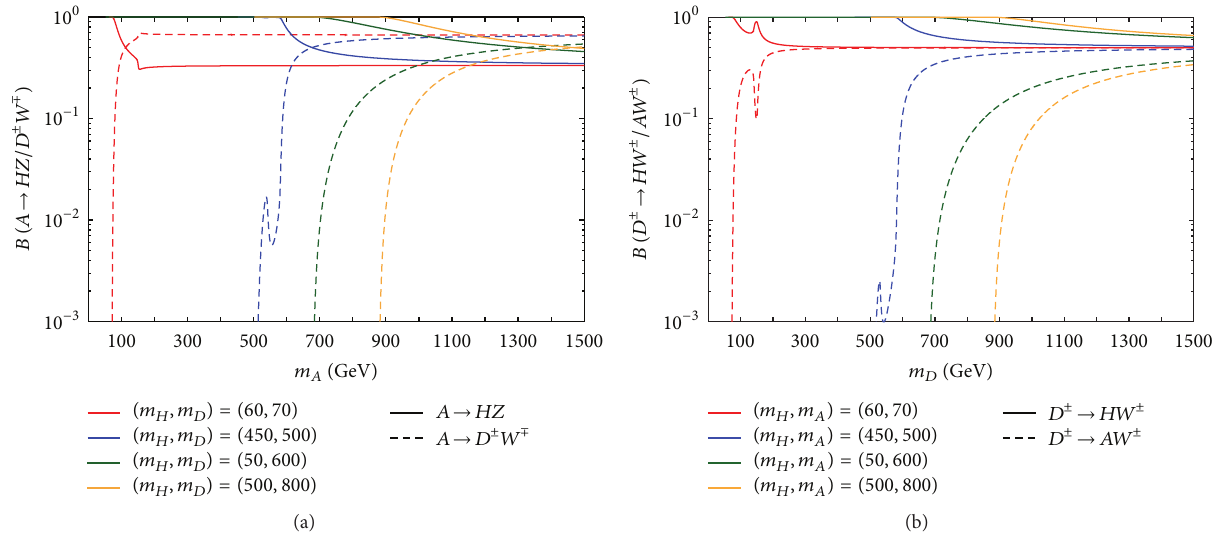
Figure 6: Branching ratios for the inert Higgs bosons 𝐴 (a) and 𝐷 ± (b) as a function of their corresponding